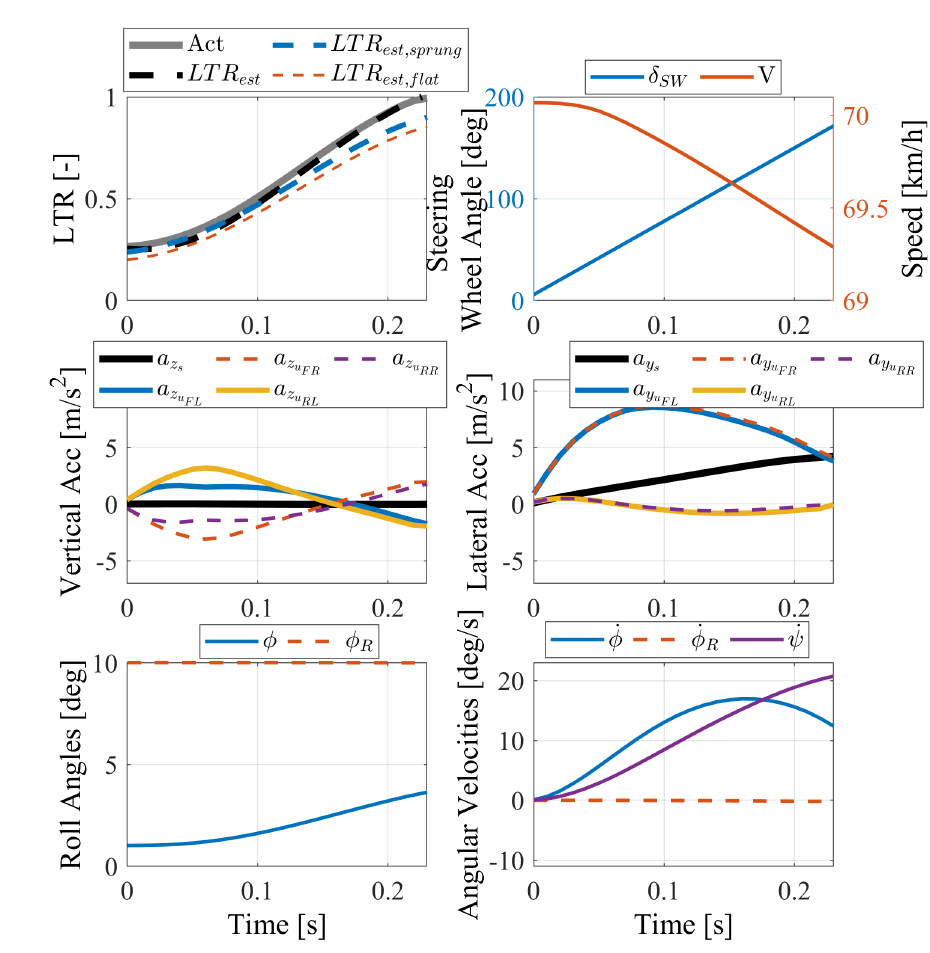
Figure 9. Fast ramp steering manoeuvre at 70km/h on a 10deg banked road. From the top left side to the down right side: LTR , steering wheel angle and vehicle speed, vertical accelerations, lateral accelerations, roll angles and angular